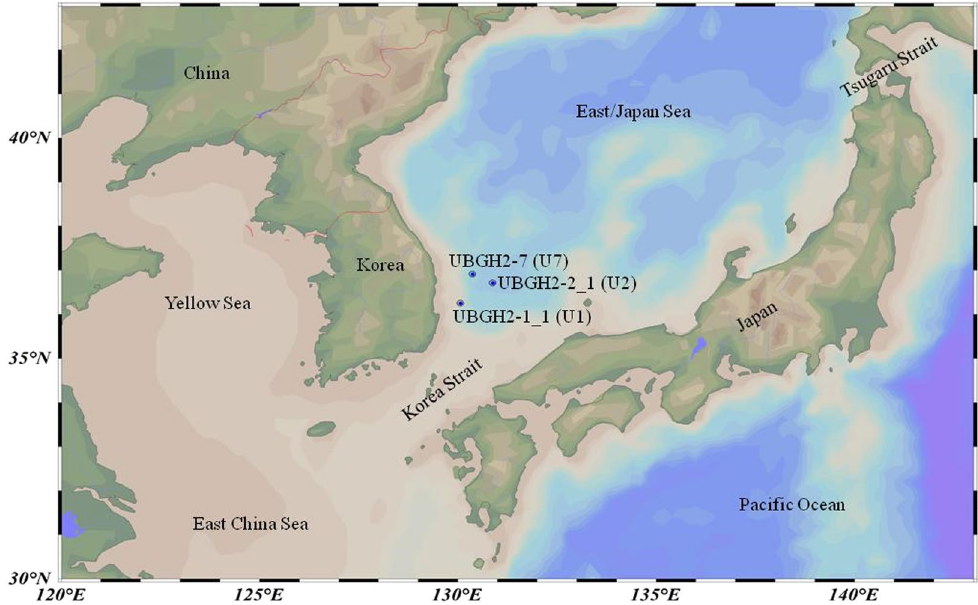
Figure 1. Sampling sites in the SW of the East Sea (Japan Sea) in the NW Pacific Ocean. Map produced with Ocean Data View version 4.7.8 (http://odv.awi.de) 56